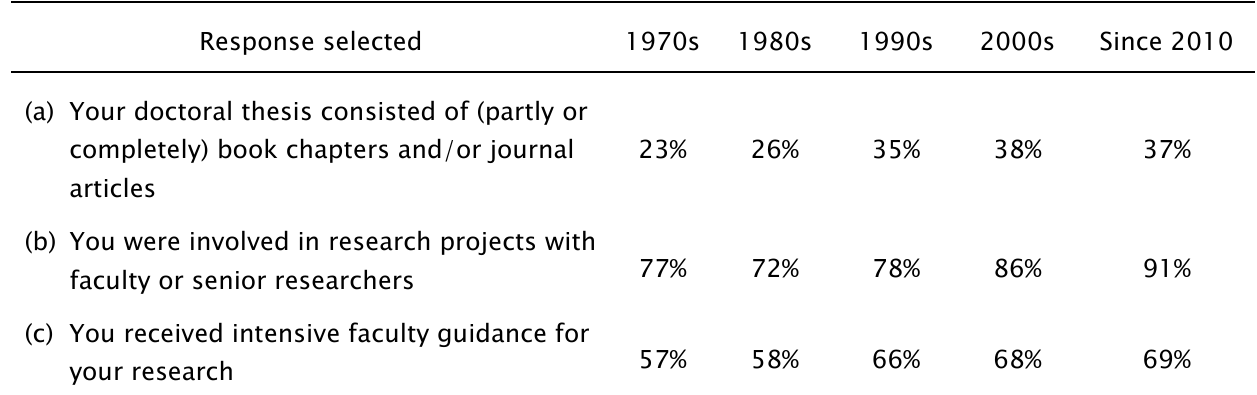
Respondents Indicating an Element (a-c) of Doctoral Study per Decade Response selected